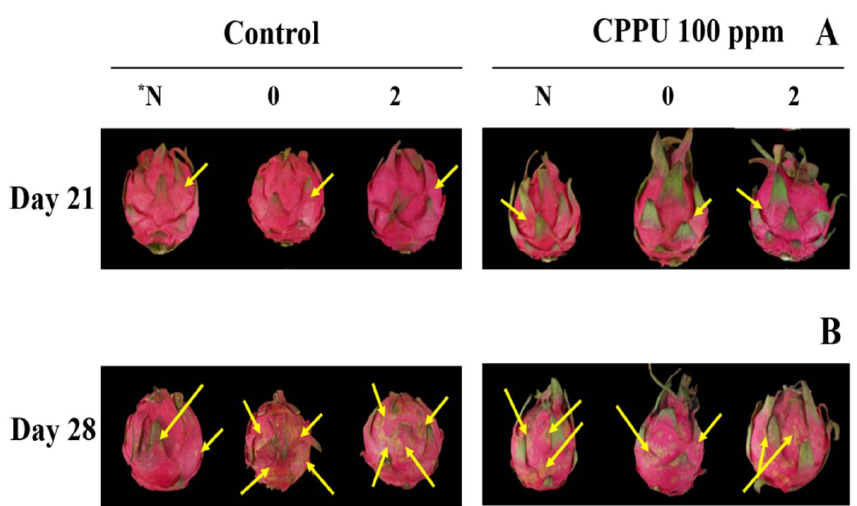
Figure 3. The effect of preharvest application of CPPU and perforation packaging on chilling injury (CI) incidence of red-fleshed pitaya ‘Da Hong’ fruit at 5 °C for 21 days storage ( A ) and transferred to 20 °C for 7 days ( B ). *N: fruit without packaging; 0: Fruit packed without perforation; 2: Fruit packed with perforation. Yellow arrows indicate chilling symptoms.